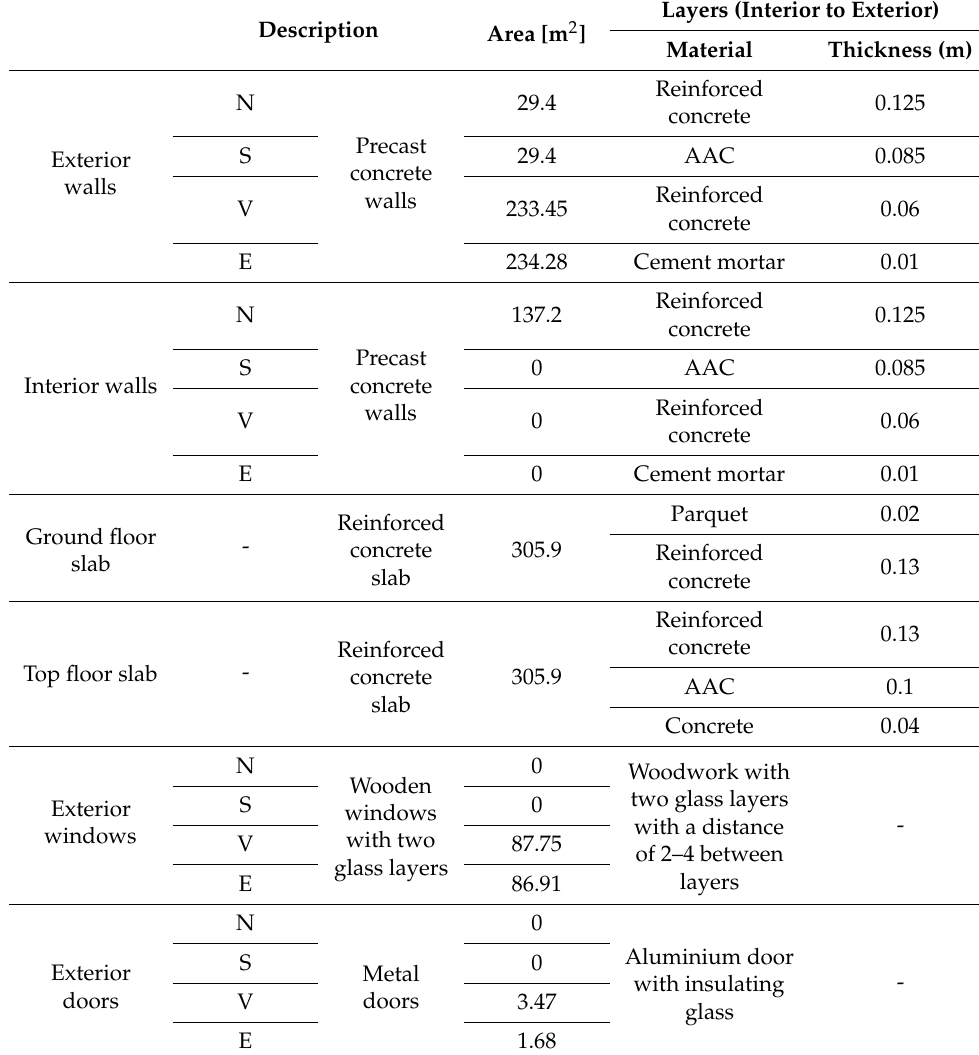
Table 1. Stratification of the elements that form the building